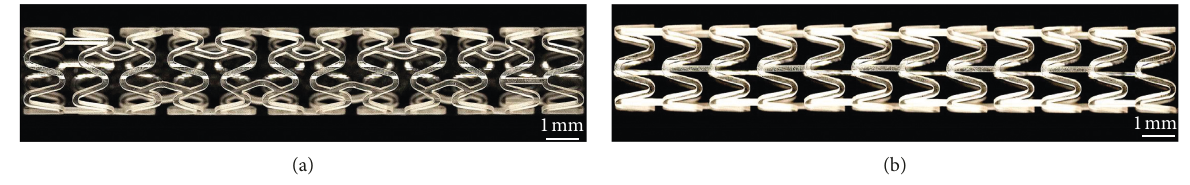
Figure 17: The fabricated stent prototypes: (a) the OCS; (b) the